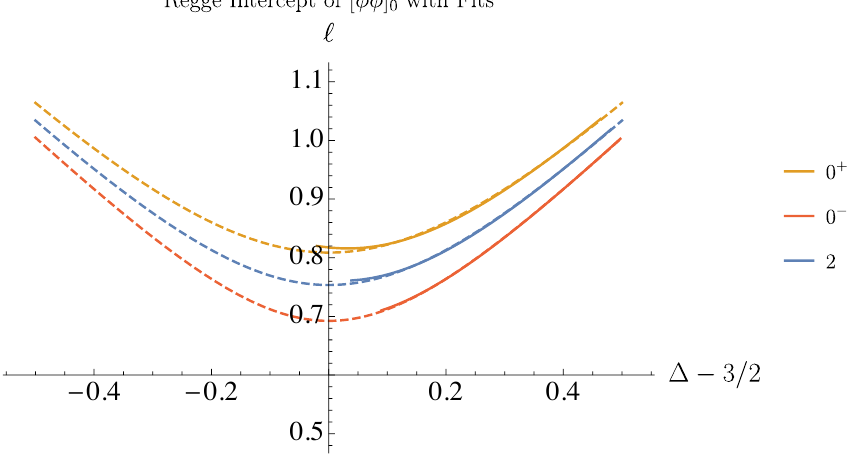
Figure 16 . The [ (cid:30)(cid:30) ] 0 (cid:6) ; 2 trajectories continued down to the intercept point (cid:1) = 3 = 2. The undotted 0 lines give the prediction from the inversion formula. The curves are truncated at h = 1 : 15 as below this value the dimensional reduction expansion converges too slowly to make reliable predictions. The dashed lines correspond to a simple shadow-symmetric quadratic (cid:12)t.